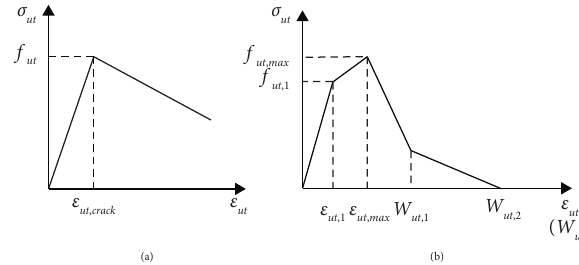
Figure 4: UHPC tensile behavior: (a) Two-stage (b) multistage.